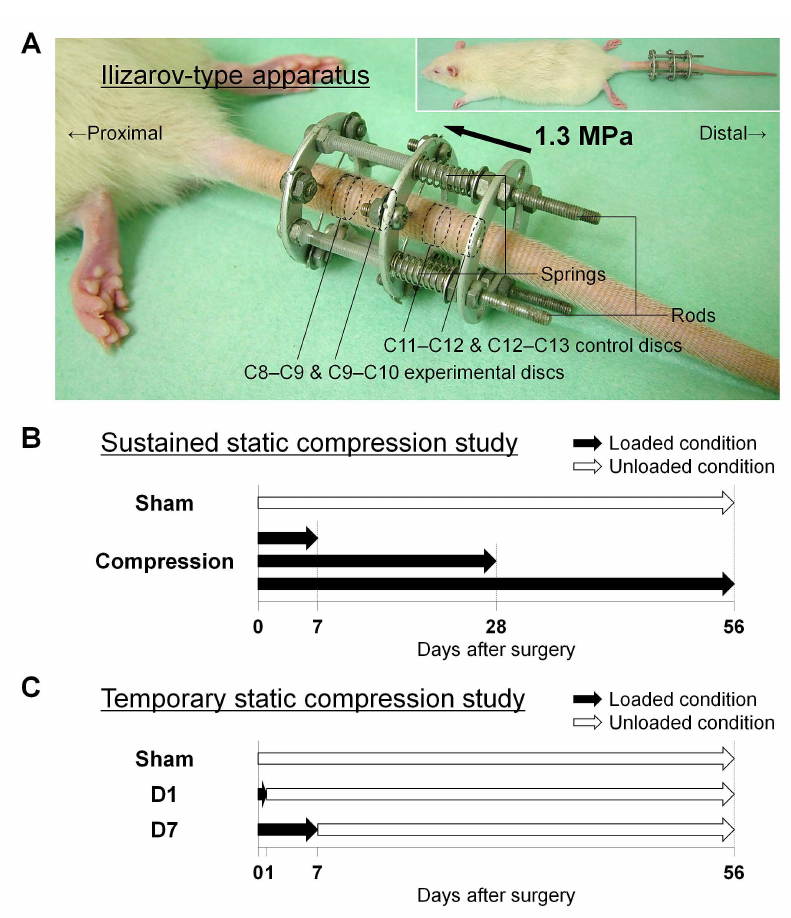
Figure 2. Rat tail sustained and temporary static compression model study. ( A ) Whole and close-up views of a rat tail instrumented with an Ilizarov-type loading device with springs and rods between the 8th and 10th coccygeal (C) vertebrae to produce axial force at 1.3 MPa. Following compression, C8–C9 and C9–C10 experimental discs and C11–C12 and C12–C13 control discs were used